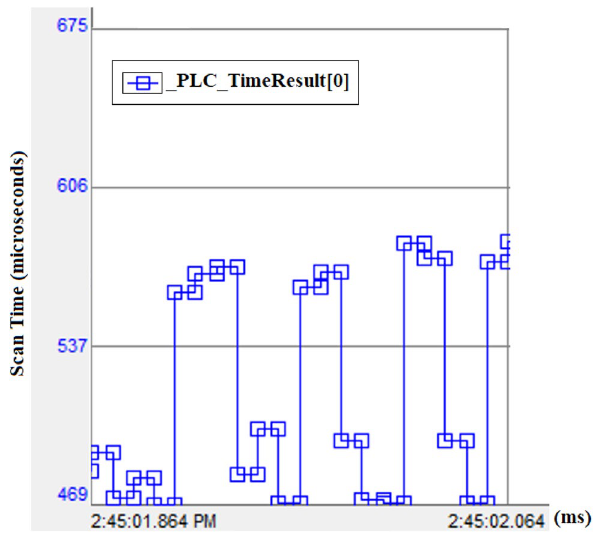
Fig. 28 Capturing several scan-time values under normal condi- tions